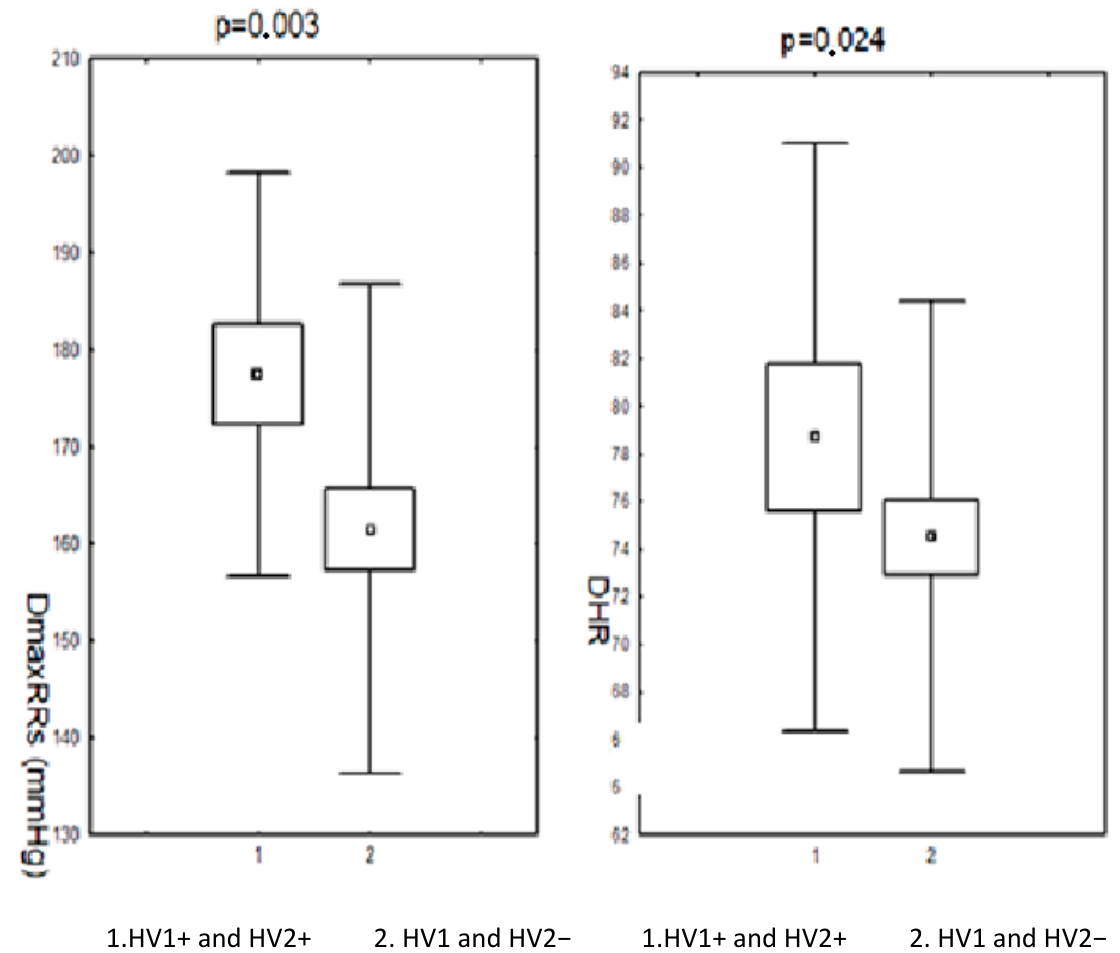
Figure 1. Results of 24 h measurements of systolic blood pressure during the day and heart rate in patients (pre- and postmenopausal) with arterial hypertension depending on changes in the nucleotide sequence in the HV1 and HV2 segment. DmaxRR—daytime maximum blood pressure; DHR—daily heart rate; HV1 and HV2+—positive for HV1 and HV2 changes; HV1 and HV2 − —negative for HV1 and HV2 changes.